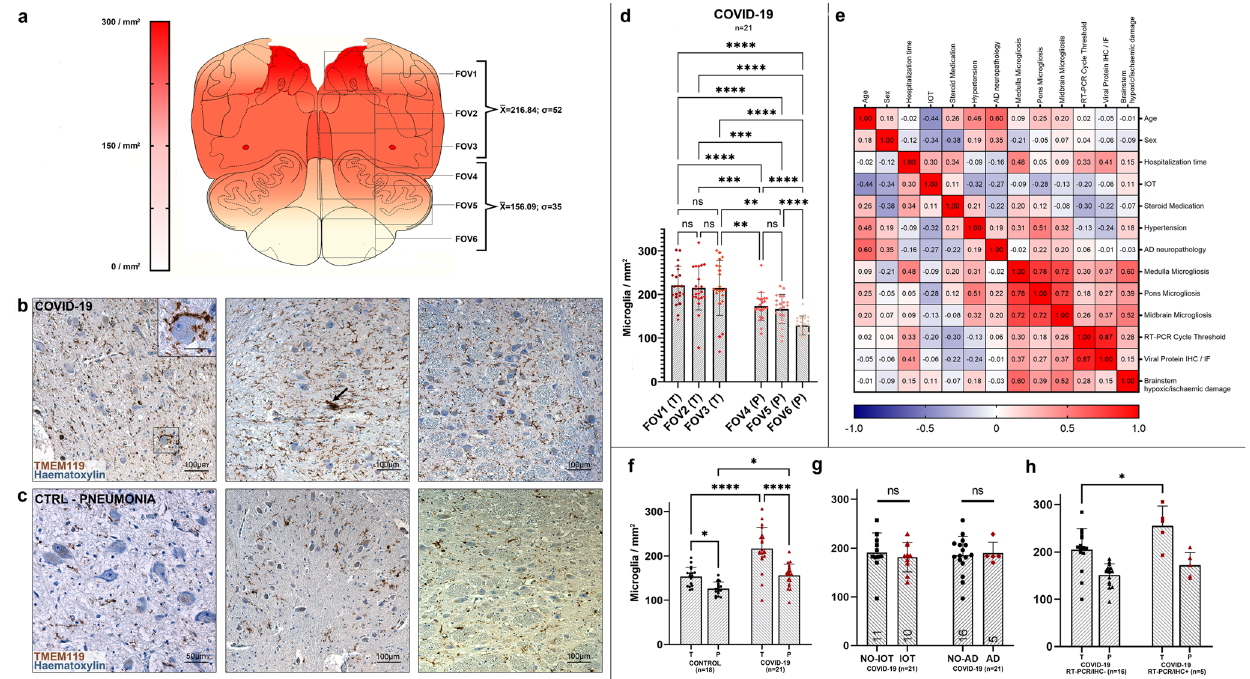
Fig. 8 Quanti fi cation of reactive microglia at the level of the medulla oblongata reveals an anatomically segregated pattern of in fl ammation. a Anatomical heatmap of activated microglia within the medulla oblongata in COVID-19. b , c TMEM119 immunoperoxidase staining of comparable regions of the medulla oblongata in COVID-19 subjects (above) and controls (below). Inset: neuronophagia in the dorsal motor nucleus of the vagus. Arrow: microglial nodule. d Welch one-way ANOVA of microglial densities per counting fi elds (FOV) reveals statistically signi fi cant differences between FOVs of the Tegmentum (T; FOV1 – 3) when compared to FOVs of the Pes (P; FOV4 – 6). e Correlation heatmap between COVID-19 subject clinical data and neuropathological fi ndings. f Welch one-way ANOVA between anatomical compartments (T, tegmentum; P, pes) between COVID-19 subjects ( n = 21, red) and controls ( n = 18, black) reveals statistically signi fi cant differences both at the level of the medullary tegmentum ( p < 0.0001) and pes ( p = 0.017). g Welch corrected t -test plot of microglial densities (microglia/mm 2 ) in the medulla oblongata of COVID-19 subjects treated ( n = 10, red) and not treated ( n = 11, black) with intensive oxygen therapy ( p > 0.05), and of COVID-19 subjects with ( n = 5, red) and without ( n = 16, black) Alzheimer ’ s disease neuropathological changes ( p > 0.05). h Welch one-way ANOVA between anatomical compartments (T, tegmentum; P, pes) between COVID-19 subjects with ( n = 5, red) and without ( n = 16) viral tropism (RT-PCR/IHC + versus RT-PCR/IHC − ) reveals statistically signi fi cant differences at the level of the medullary tegmentum ( p = 0.017). Error bars indicate standard